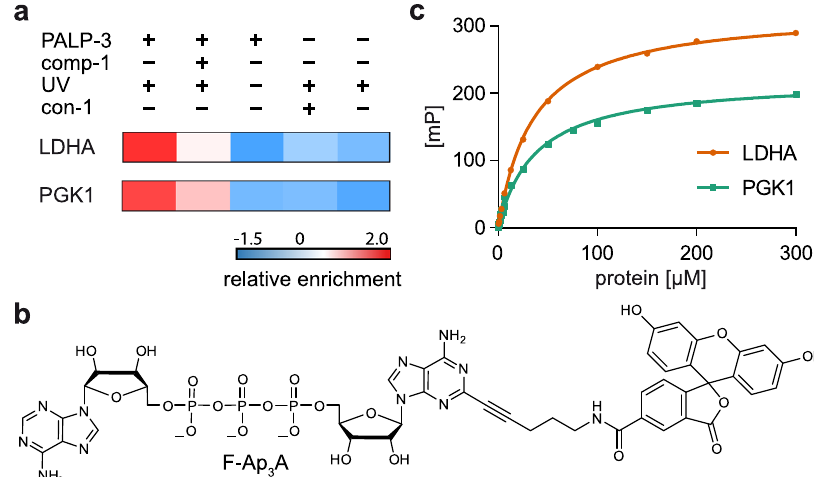
Fig. 6 Investigation of the binding af fi nity of LDHA and PGK1 to the fl uorescent labeled Ap 3 A analog F-Ap 3 A via fl uorescence polarization (FP). a Extract of ANOVA-heatmap ( Z -scores) for LDHA and PGK1 under different PAL conditions. b Chemical structure of F-Ap 3 A. c FP-based quanti fi cation of binding between LDHA (orange) or PGK1 (green) to F-Ap 3 A. Increasing concentrations of protein were incubated with F-Ap 3 A (25 n M ) for 15 min on ice and 30 min at 30 °C before measurement. FP values were determined and plotted against the protein concentrations. Data presented are mean ± SD, n = 3 technical replicates. Source data are provided as a Source Data fi